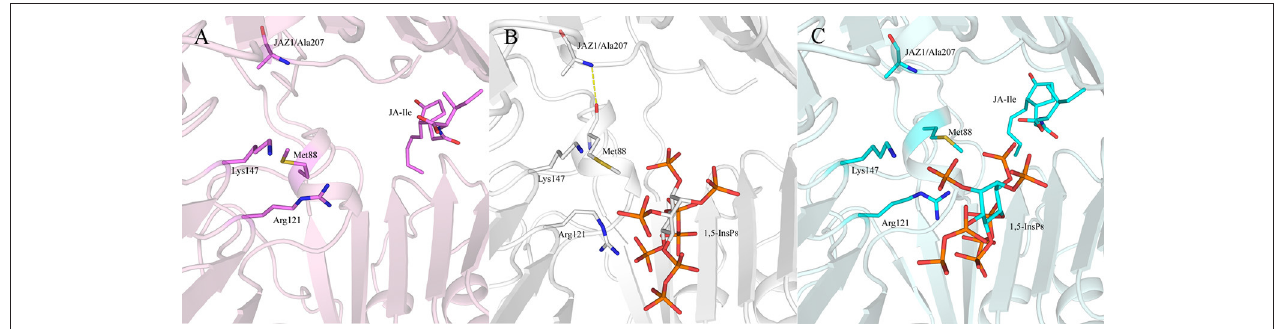
FIGURE 9 | The interaction between 1,5-InsP 8 , JA-Ile, JAZ1 and COI1 (Met88, Arg121, Lys147) from the last 20 ns of the MD trajectories. (A) system 4 (COI1 + ASK1 + JAZ1 + JA-Ile); (B) system 5 (COI1 + ASK1 + JAZ1 + 1,5-InsP 8 ); (C) system 6 (COI1 + ASK1 + JAZ1 + 1,5-InsP 8 + JA-Ile). The carbon atoms of residues or ligands are colored by pink, white, and cyan in systems 4, 5, and 6, respectively. The COI1 and JAZ1 are colored by light pink, white, and palecyan in system 4, system 5, and system 6, respectively.